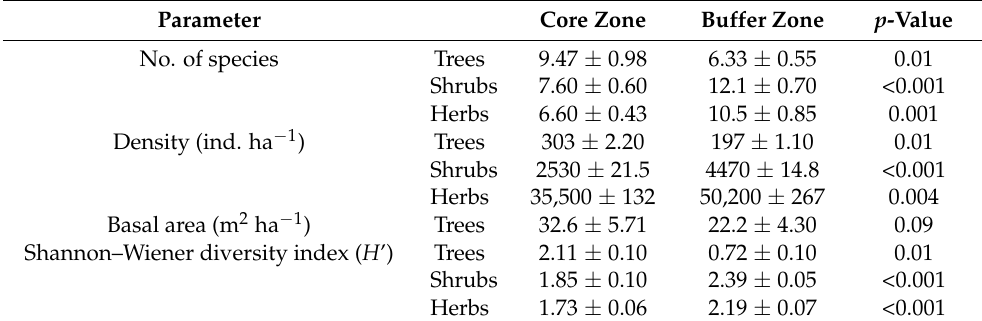
Table 1. Structural attributes and diversity (mean ± standard error) of trees, shrubs, and herbs in core and buffer zones of Minkong Community Reserve Forest, Nagaland,